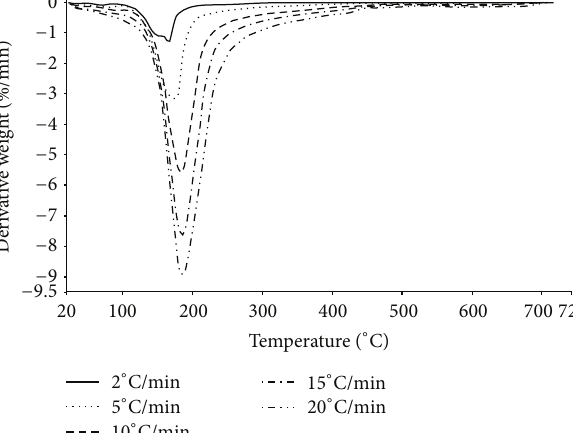
Ozawa and KAS nonisothermal kinetic methods were applied for conversion values (𝛼) between 0.1 and 0.9. In the Ozawa kinetic method, log (𝛽) values were plotted against 1/𝑇 values for each 𝛼 value (Figure 9). For each heating rate kinetic parameter of 𝐸 𝑎 was calculated from the slope of the curves. Likewise, in the KAS kinetic method, ln (𝛽/𝑇 2 ) was plotted against 1/𝑇 for each 𝛼 value (Figure 10). Kinetic